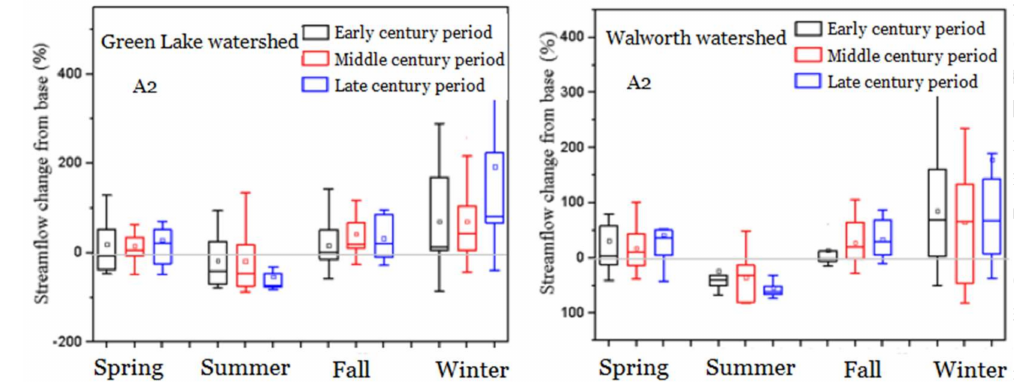
Figure 5. Seasonal changes of streamflow at the Green Lake watershed and Walworth watershed under the A2 scenarios. ( left ): Green Lake watershed, ( right ): Walworth